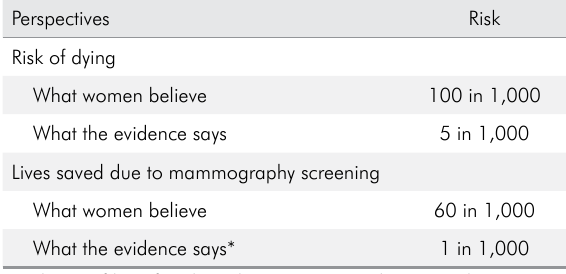
Table. Risk of dying from breast cancer in the next ten years in a group of well-educated American women, aged 40–49, with no history of breast